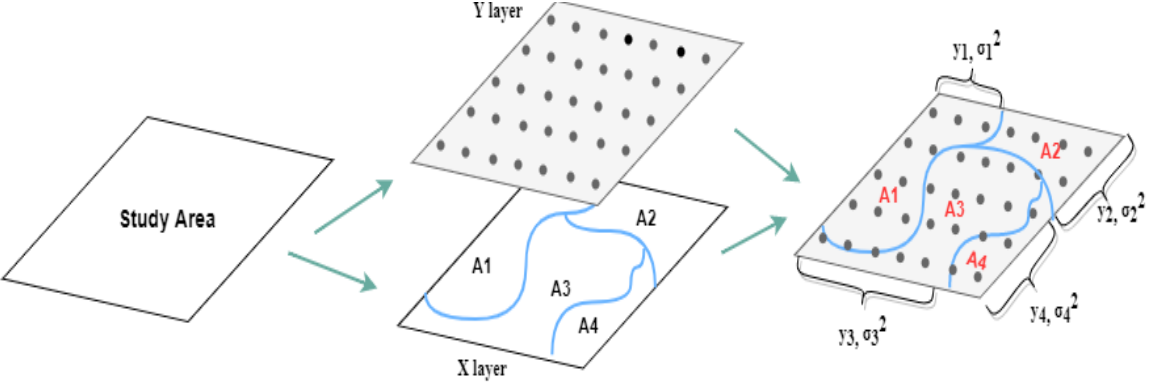
Figure 2. The principle of the geographical detector (Source:[44] Wang & Xu, 2017).